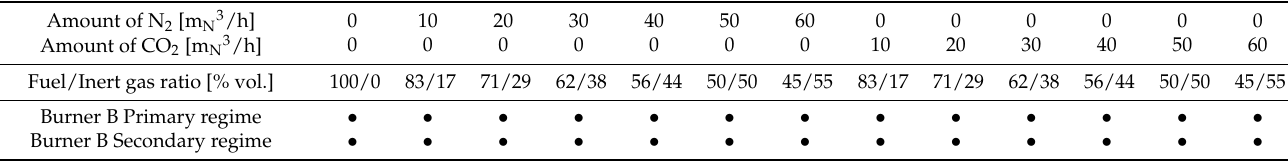
Table 4. Experimental matrix—TEST A—Burner B ( • indicates that the test was carried out). Amount of N 2 [m N3 /h]